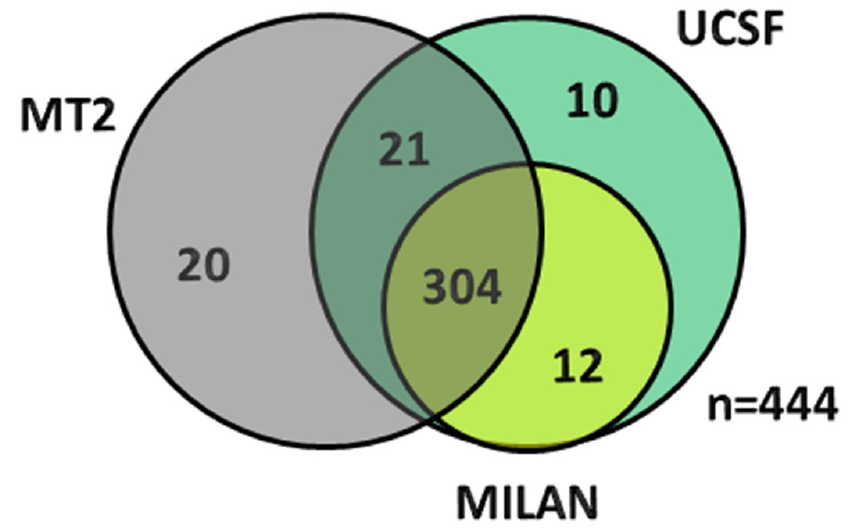
Figure 4. Venn diagram depicting the overlap of patients across the different criteria (Milan, UCSF and Metroticket 2.0) based on the re-categorisation of patients based on the Metroticket 2.0 using post-LT (pathological) information on all patients (77 patients were found to lie outside all the cri- teria).